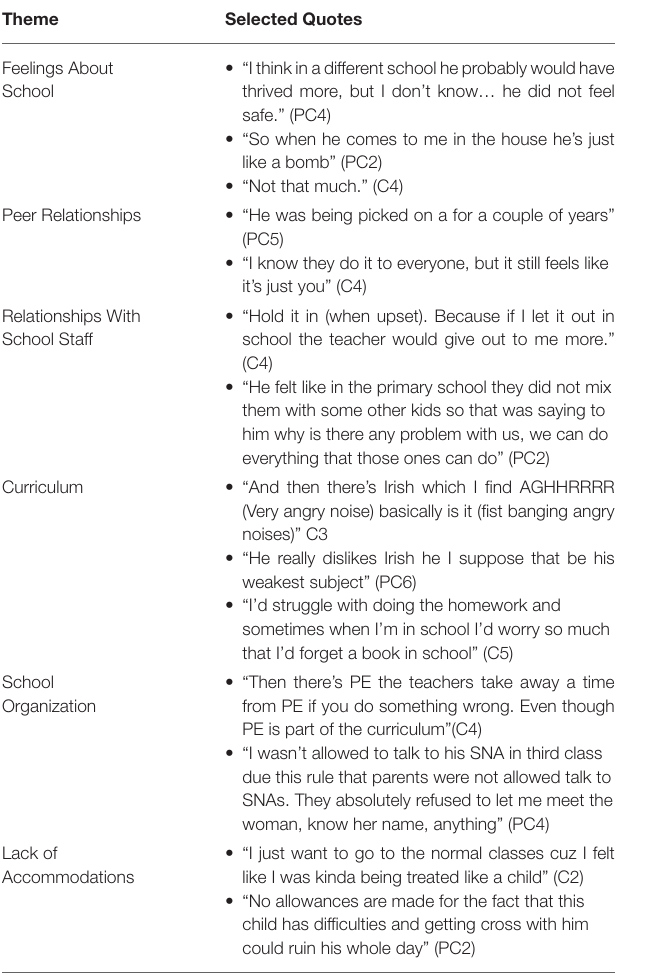
TABLE 4 | Misfits pre-transition. TABLE 5 | Misfits